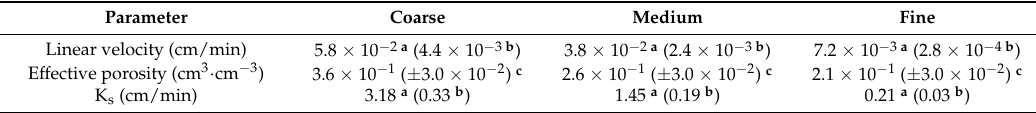
Table 4. Estimated mean and standard deviation of parameters for the breakthrough curve analyses.